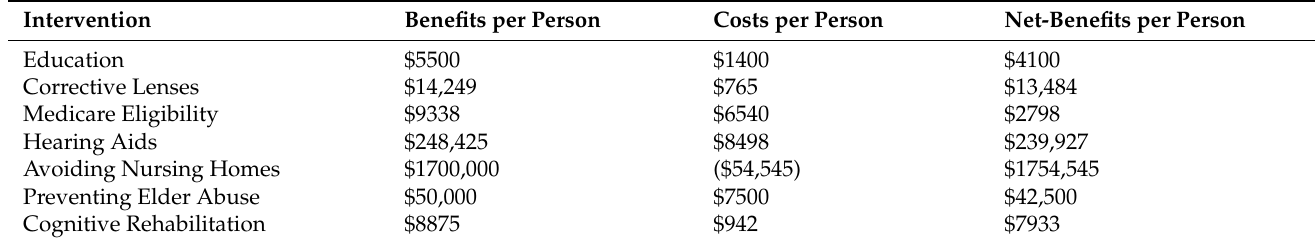
Table 5. Net Benefits of Various Dementia